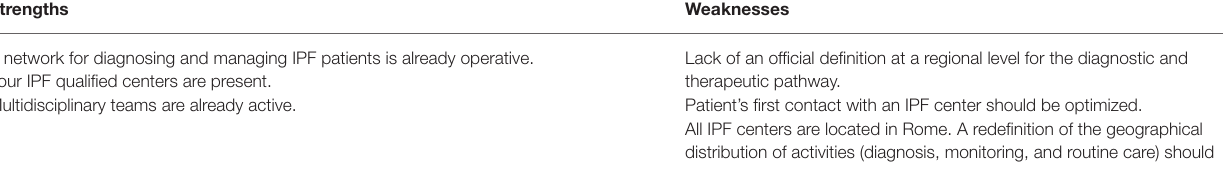
TABLE 3 | SWOT analysis of the IPF model of care from 2015 to 2018. Strengths Weaknesses